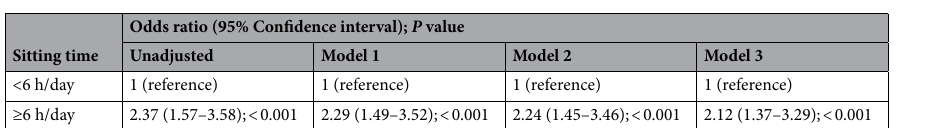
Table 2. Multivariate analysis of relationships of low tertiles with FMD and sitting time on a non-working day. Model 1; adjusted for age, gender, body mass index, hypertension, dyslipidemia, diabetes mellitus, current smoking. Model 2; adjusted for age, gender, body mass index, hypertension, dyslipidemia, diabetes mellitus, current smoking, past CVD. Model 3; adjusted for age, gender, body mass index, hypertension, dyslipidemia, diabetes mellitus, current smoking, past CVD, exercise habit. FMD indicates flow mediated vasodilation; OR, odds ratio; CI, confidence interval. Low tertile of FMD indicates less than 1.6%.